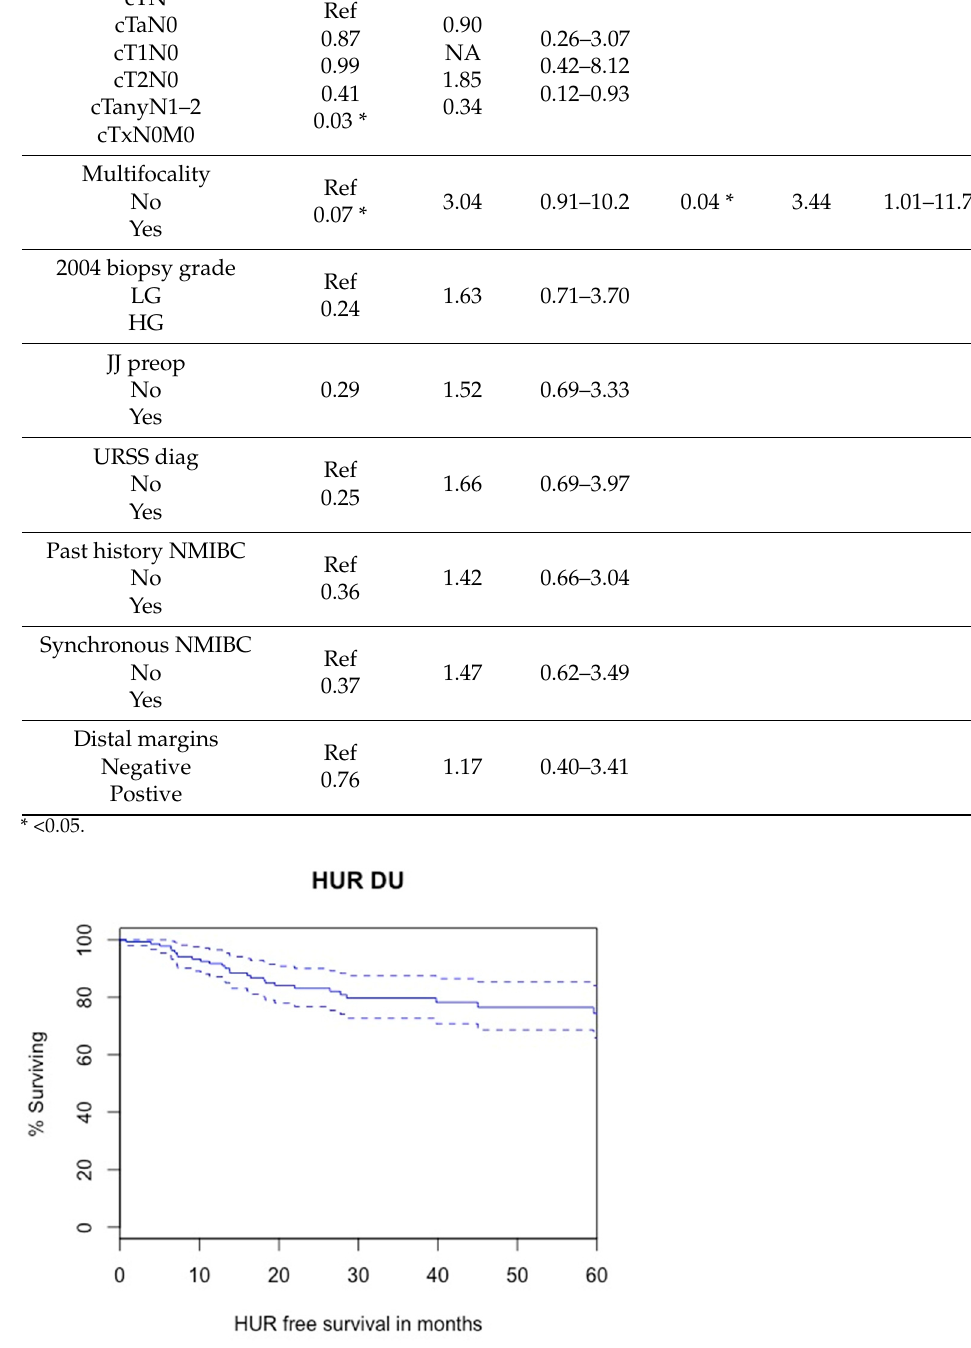
Figure 5. Kaplan–Meier modelling of homolateral upper tact recurrence (5-year HUR free survival: 74.4%, lower – upper 95% CI 0.658 - 0.840). Table 6. Cox regression for factors associated with HUR.